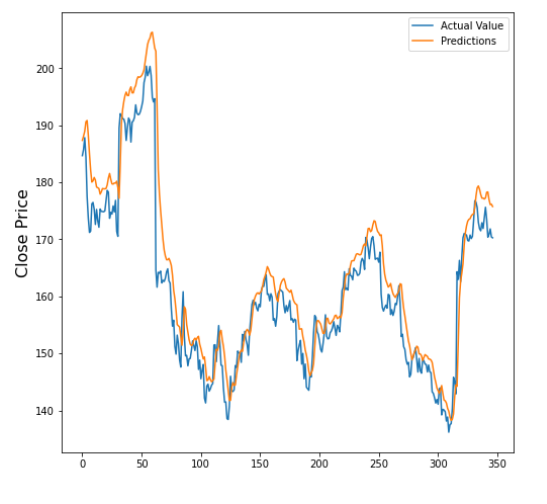
Now we convert data into time series ans apply ML Models